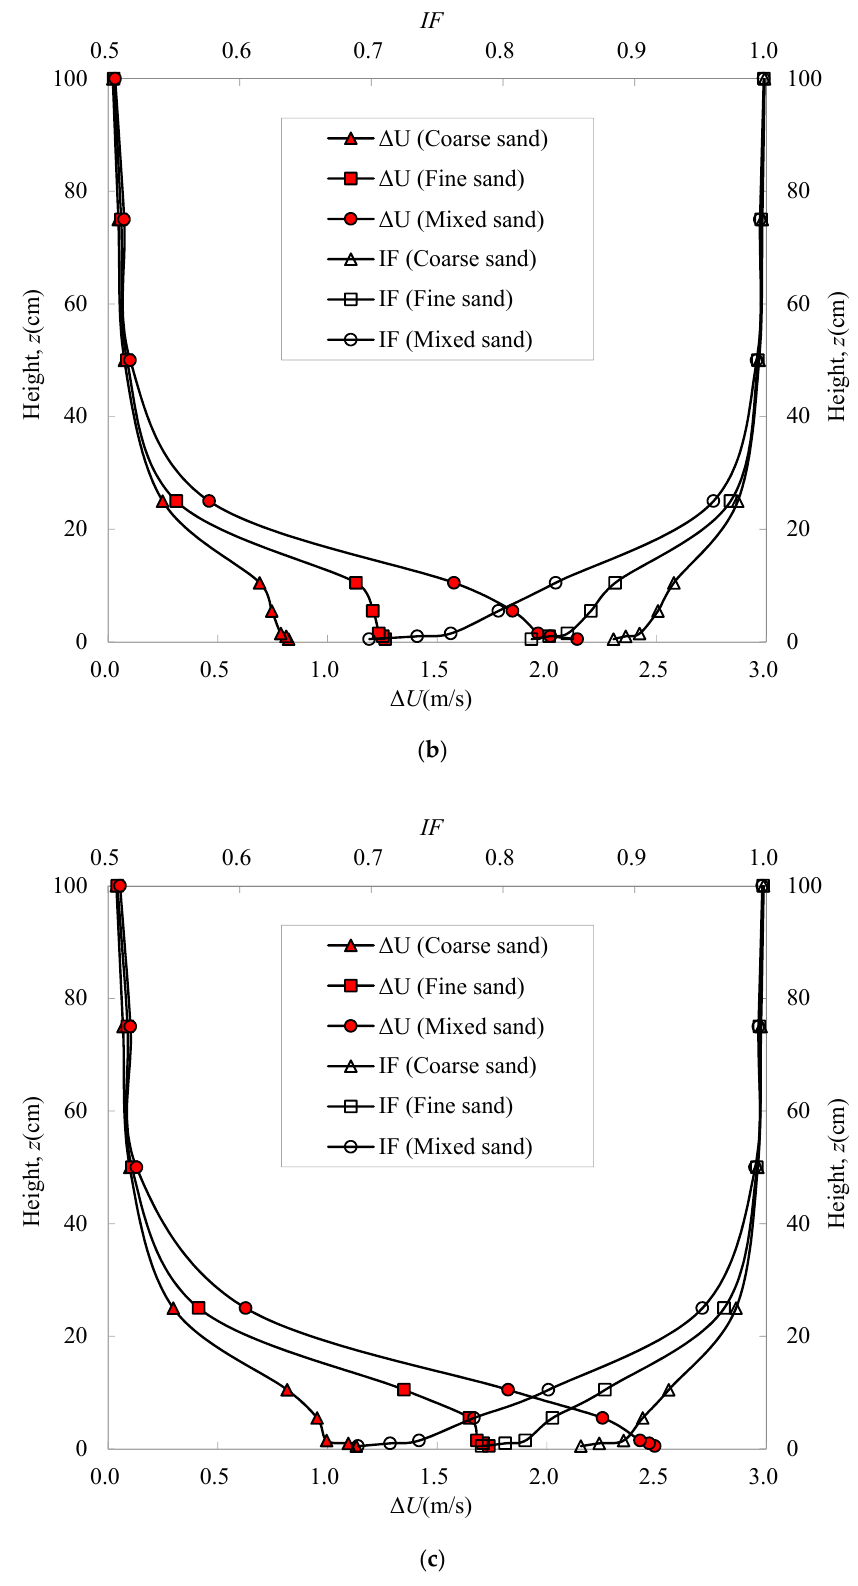
Figure 11. The influence of particle movement on the wind speed: ( a ) At the indicated wind speed of 14.74 m/s; ( b ) At the indicated wind speed of 16.68 m/s; ( c ) At the indicated wind speed of 18.61